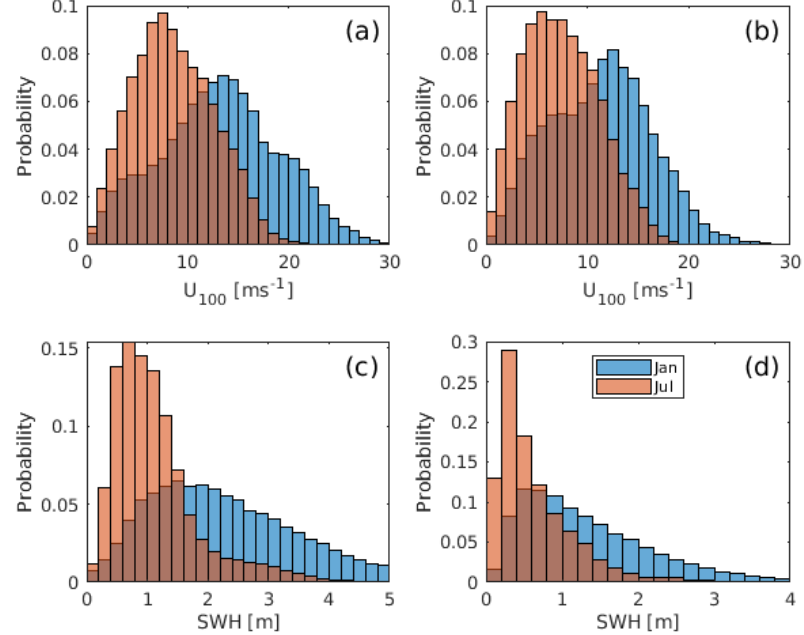
Figure 4. The normalized distribution of wind ( a , b ) and wave ( c , d ) for the North Sea ( a , c ) and the Baltic Sea ( b , d ) in January and July 2015. Data are from